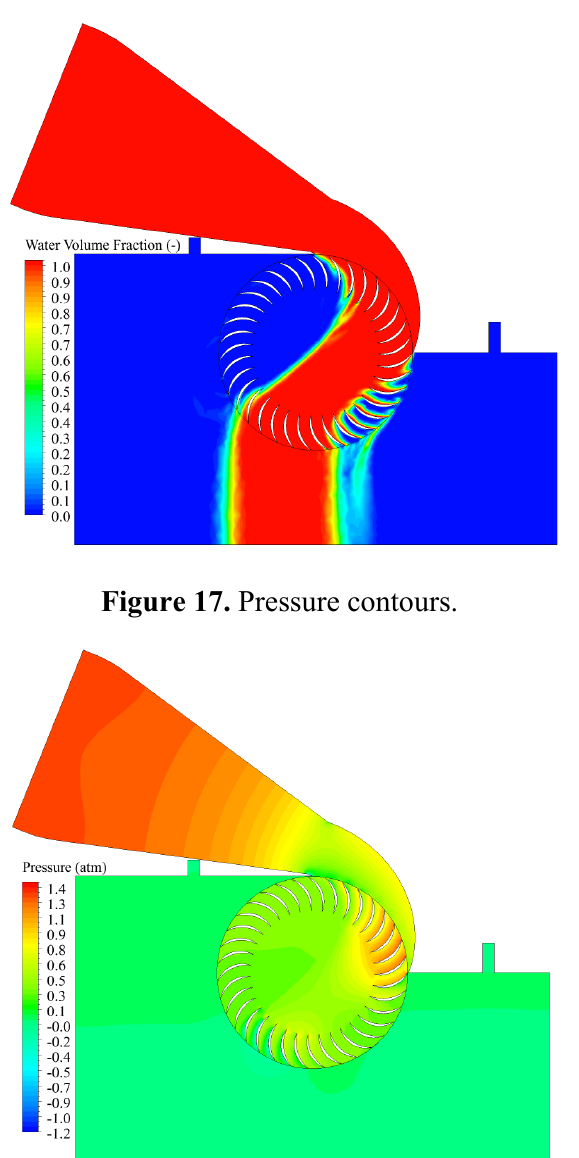
Figure 16. Water volume fraction contours.